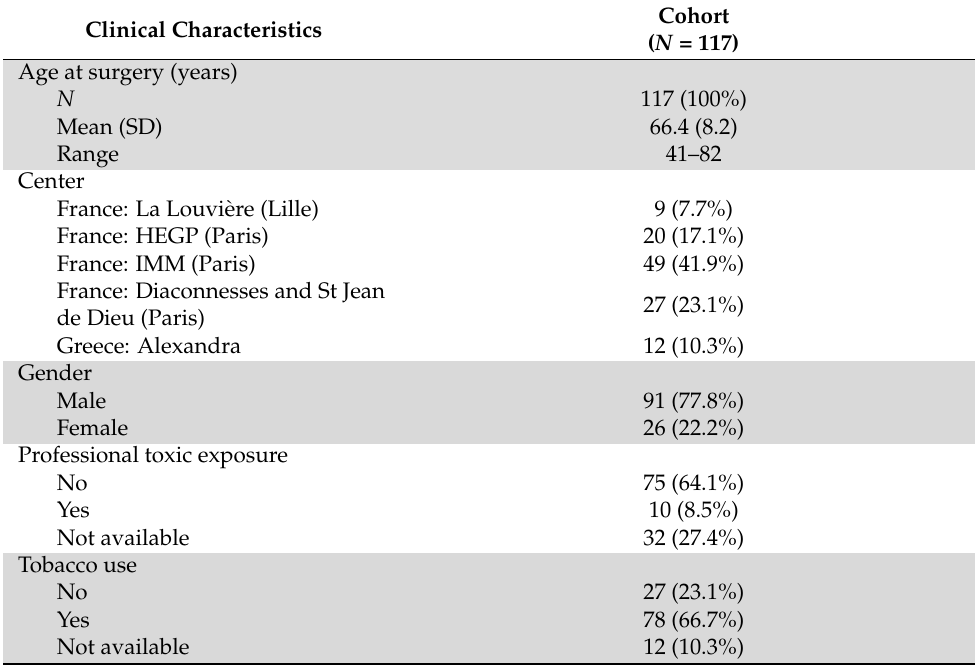
Table 1. Clinical